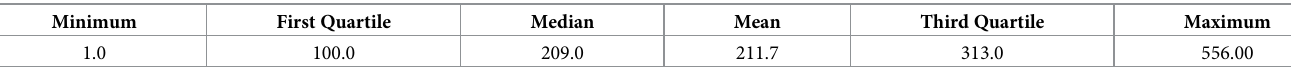
556. Table 6 shows the summary statistics for the real data. Fig 9 is the TTT plots of the dataset which shows a non decreasing curve. Fig 10 shows the fitted plot of the data using the MBTED Table 6. Table displaying descriptive analysis of recidivism failure time